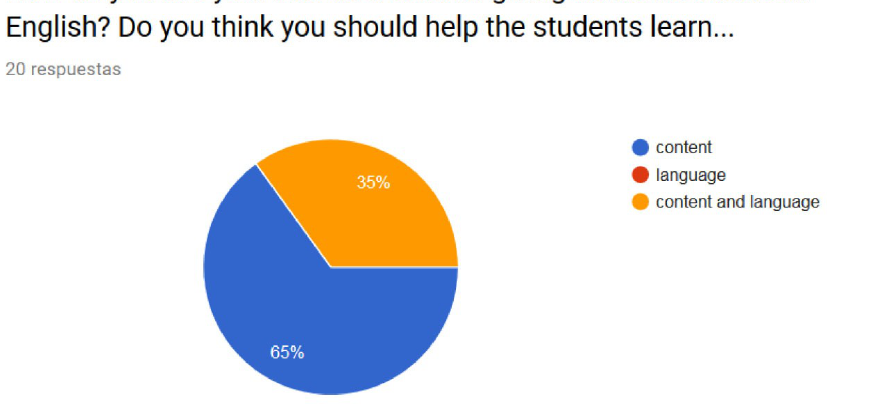
Figure 4. Role as a teacher giving content